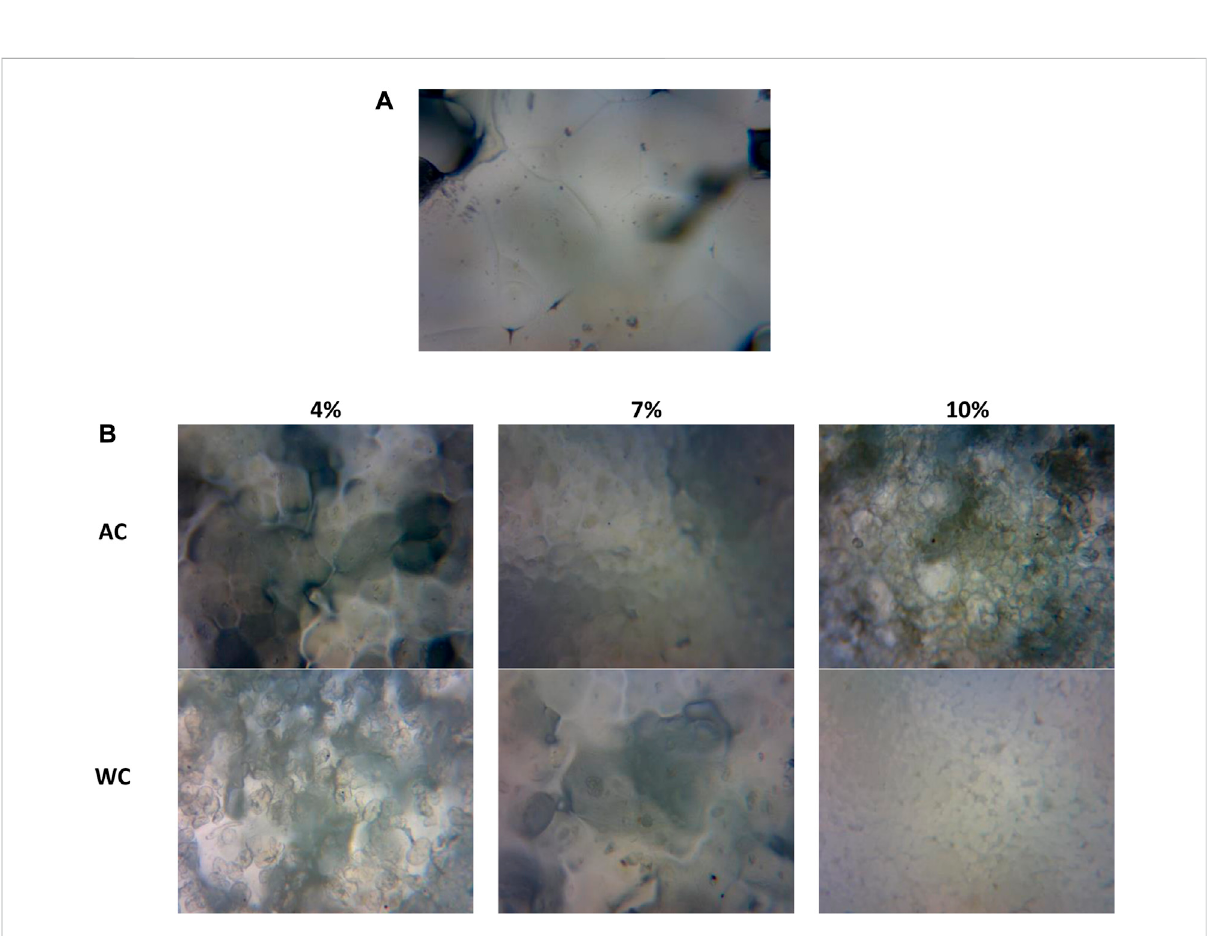
FIGURE 10 Optical images of: (A) PLA and (B) PLA composites loaded with WC and AC.